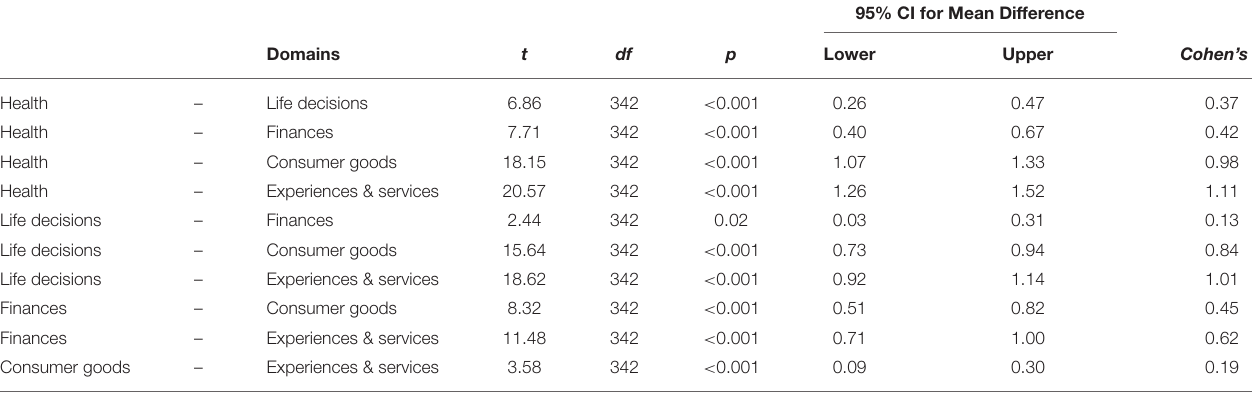
Student’s t-test.